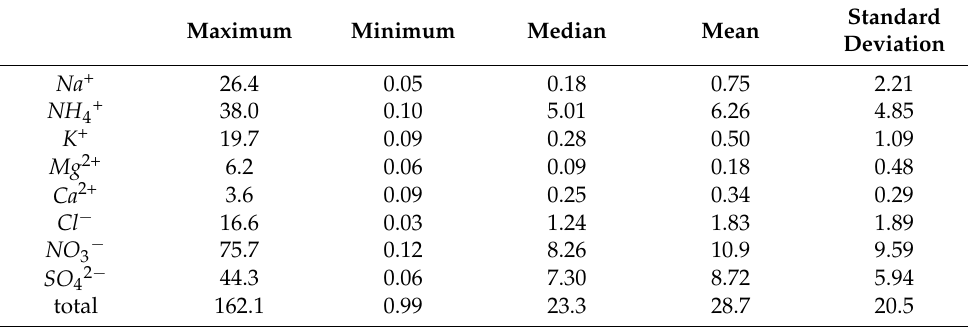
Table 2. Concentrations of NO 3 − and SO 42 − and values of NO 3 − to SO 42 − in PM 2.5 measured by different research at Nanjing ( μ g·m − 3 ).